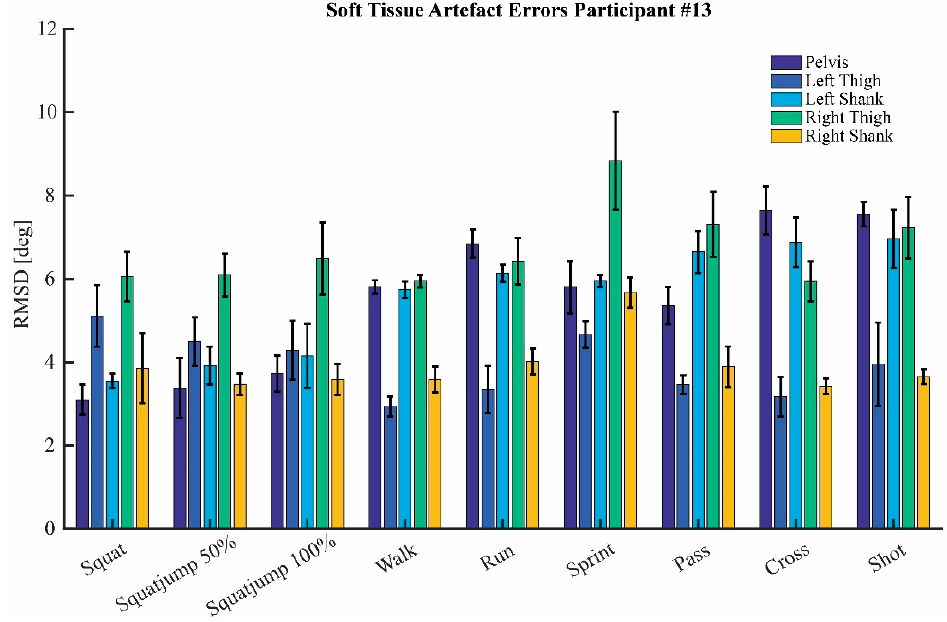
Figure A5. Error caused by the soft tissue artefact of a typical subject. Mean root-mean-square differences (RMSD) and standard deviations for all body segments and all trials.